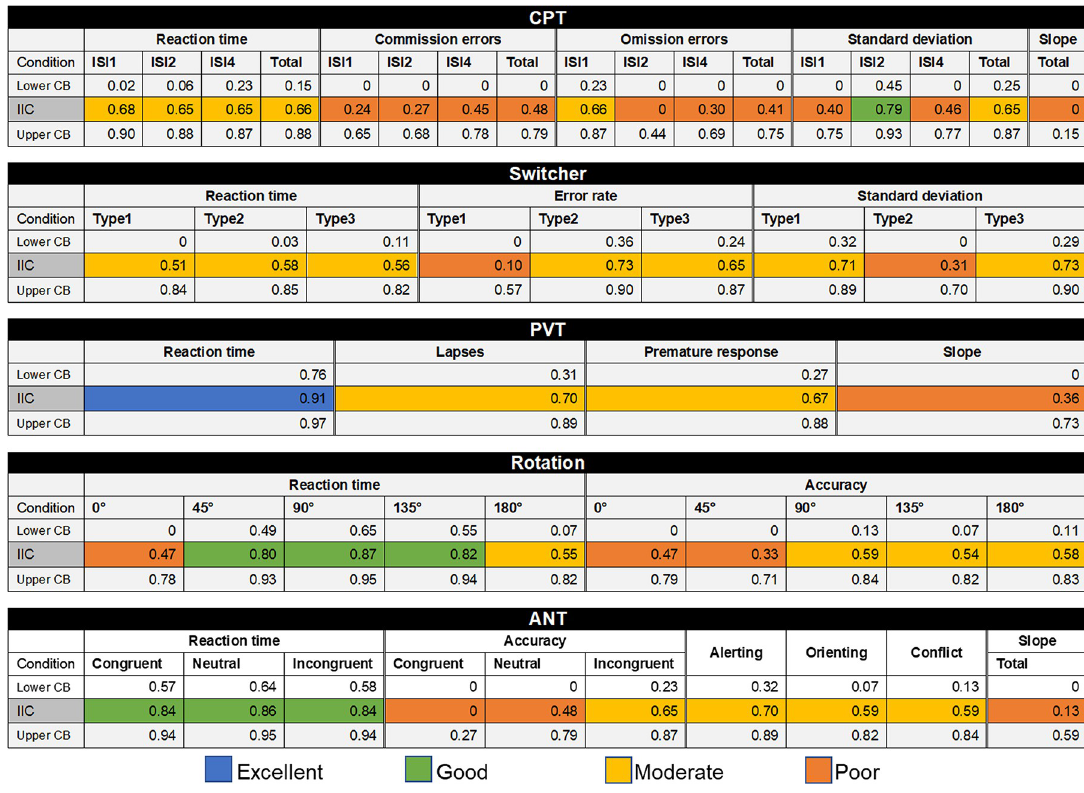
Fig 2. Intraclass Correlation Coefficients (ICC) of task scores for a one-week test-retest application with 15 participants. CPT = Continuous Performance Task; PVT = Psychomotor Vigilance Task; ANT = Attention Network Test; ISI1, ISI2, ISI4 = inter- stimulus interval of 1, 2, and 4 s, respectively; Type1, Type2, and Type3 = alternate switch, fixed switch, and random switch, respectively, CB = confidence boundary. Blue, green, yellow, and orange colors indicate excellent (ICC � 0.9), good (0.75 � ICC < 0.9), moderate (0.5 � ICC < 0.75), and poor (ICC < 0.5) ICC values.